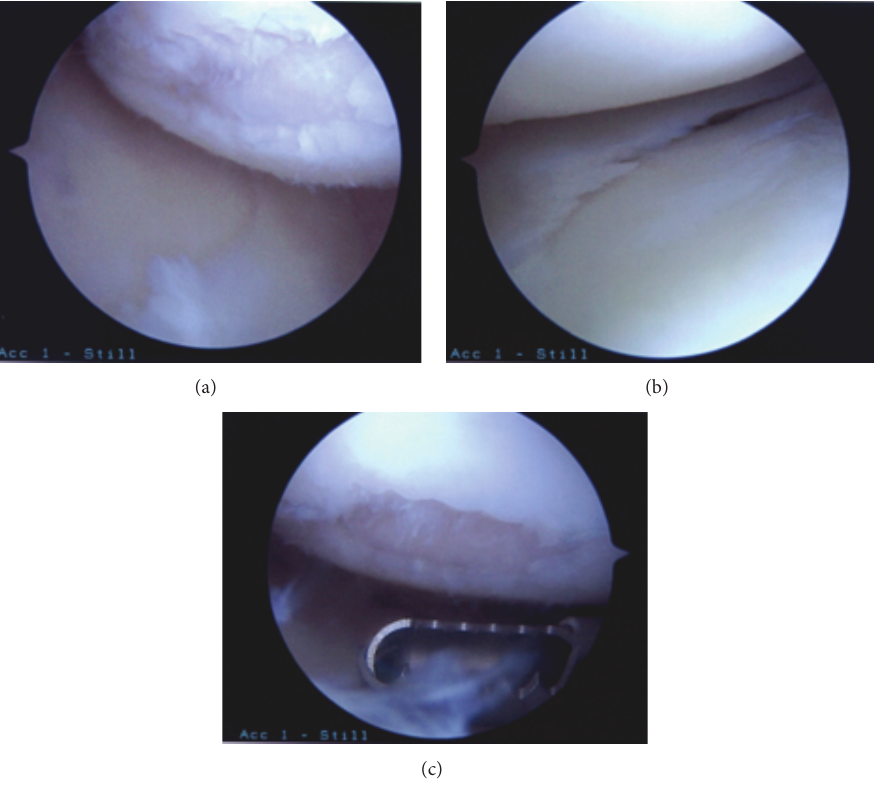
Figure 3: Arthroscopic images depicting arthritic changes in the same 39-year-old female patient described in Figure 1, who underwent ACL reconstruction with medial meniscectomy at the age of 33 after sustaining an ACL tear with concomitant medial meniscus and MCL